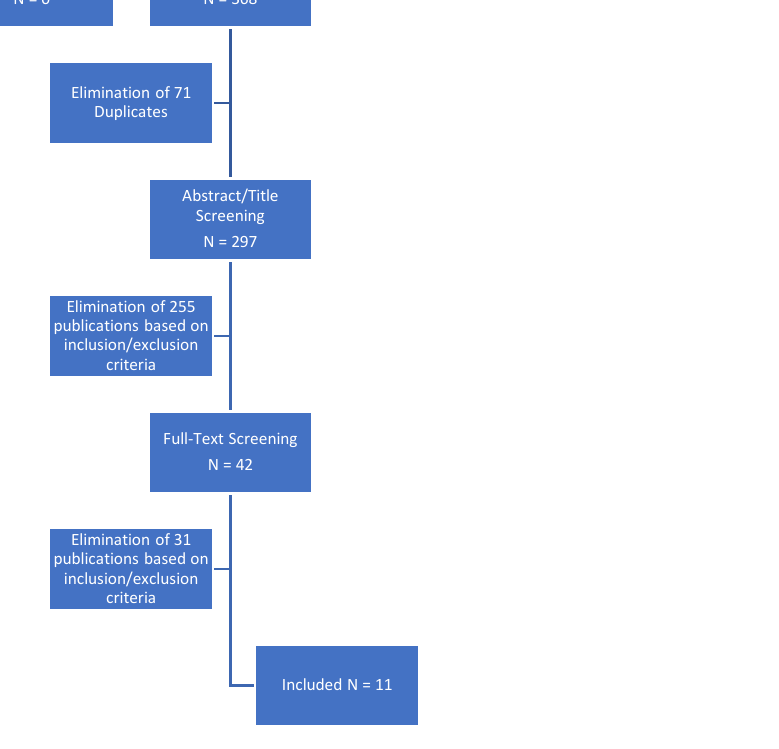
Figure 1. Flowchart of study selection process.